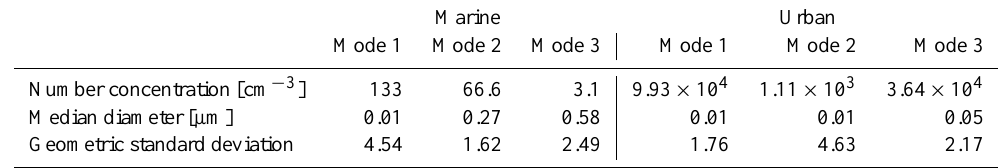
Table 3. Background aerosol size distributions used for sensitivity studies. From Seinfeld and Pandis (2006).